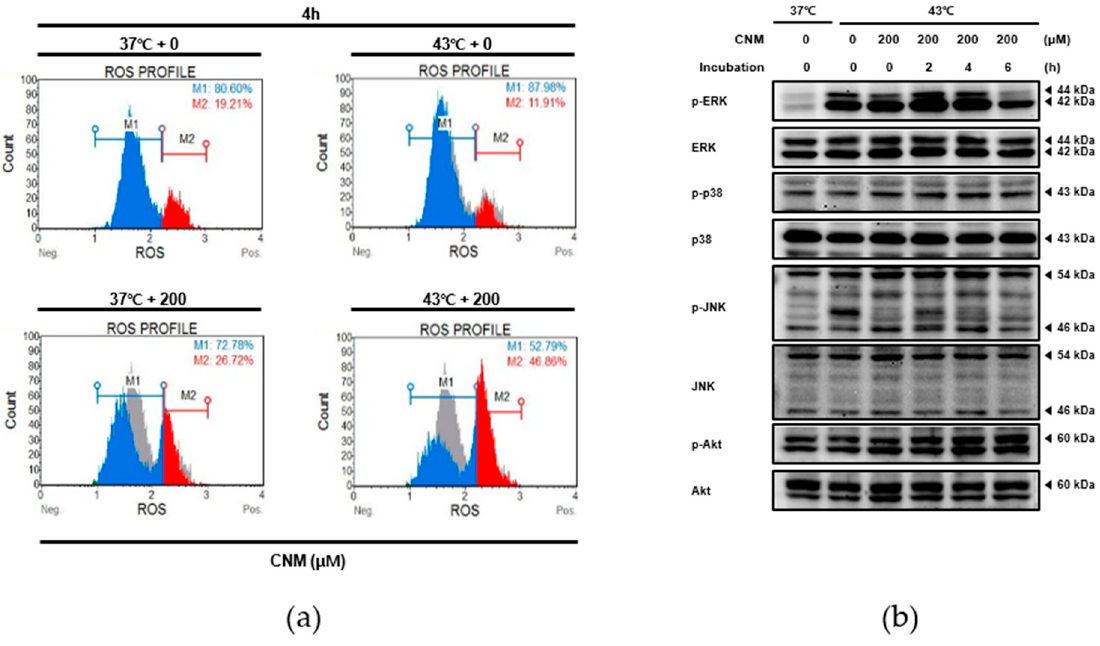
Figure 5. Effect of CNM and hyperthermia combination therapy on reactive oxygen species (ROS) generation and MAPK pathway in A549 cells. A549 cells were treated with CNM (0 or 200 μ M) with or without hyperthermia and incubated for the indicated time. ( a ) Flow cytometry analysis on ROS generation was performed; ( b ) Protein expressions of p-ERK, ERK, p-JNK, JNK, p-p38, p38, p-Akt and Akt were measured using western blot assays. Representative blots are shown.